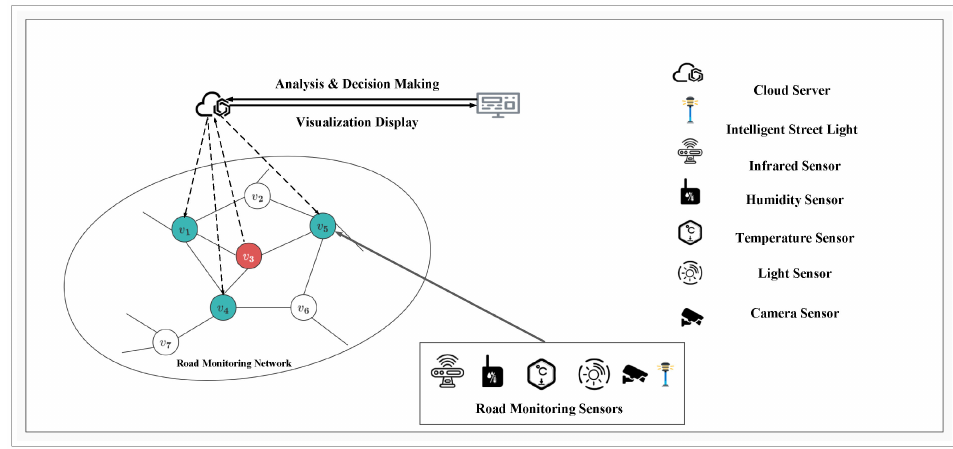
Figure 3. The road traffic situation cooperative monitoring model under